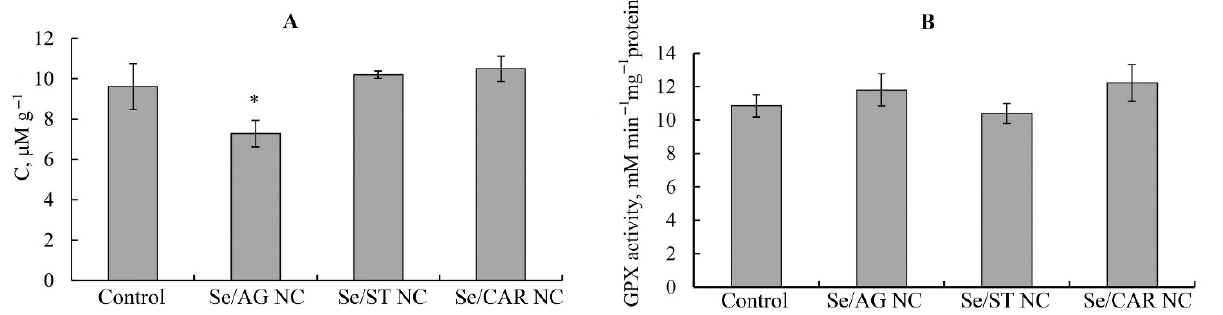
Figure 2. Effect of selenium (Se) nanocomposites (NCs) on the content of diene conjugates (DC) ( A ) and on glutathione peroxidase (GPX) activity ( B ) measured in the parental potato tuber shoot tissues after 14 days of sprouting following treatment and in the control (mean value of µ M per g of wet weight); the vertical bars indicate the standard error ( ± SE); * Significant difference from control, p < 0.05 based on Mann–Whitney U test of shoots in 30 tubers per each treatment and control. Se/AG NC, Se/ST NC and Se/CAR NC are arabinogalactan-, starch- and Table 2. Mean length and weight of potato shoots † (±SE) measured in the parental tubers after 14 days of sprouting following treatment with selenium (Se) nanocomposites (NCs) and in the control.